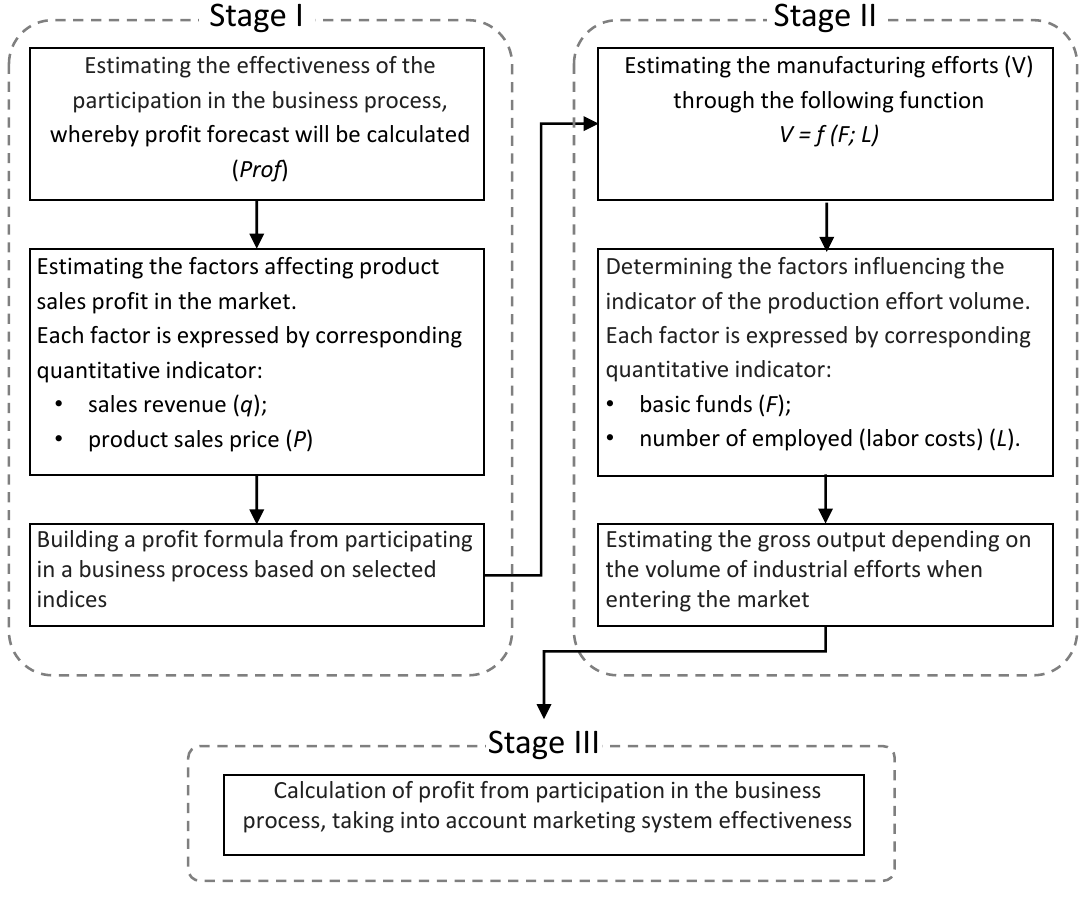
Figure 2. Model of enterprise profit forecasting depending on the effectiveness of the marketing